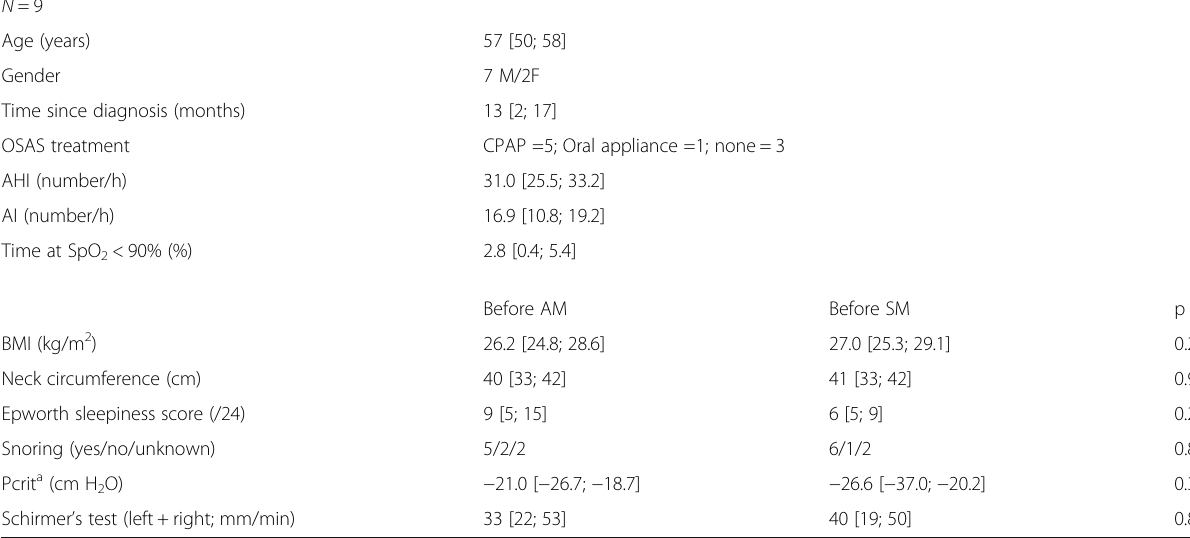
Table 1 Baseline characteristics